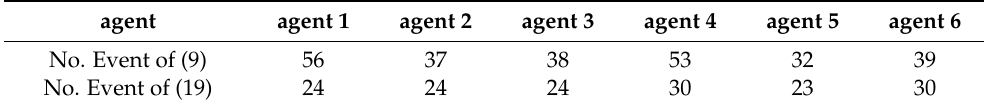
Table 1. The number of events per